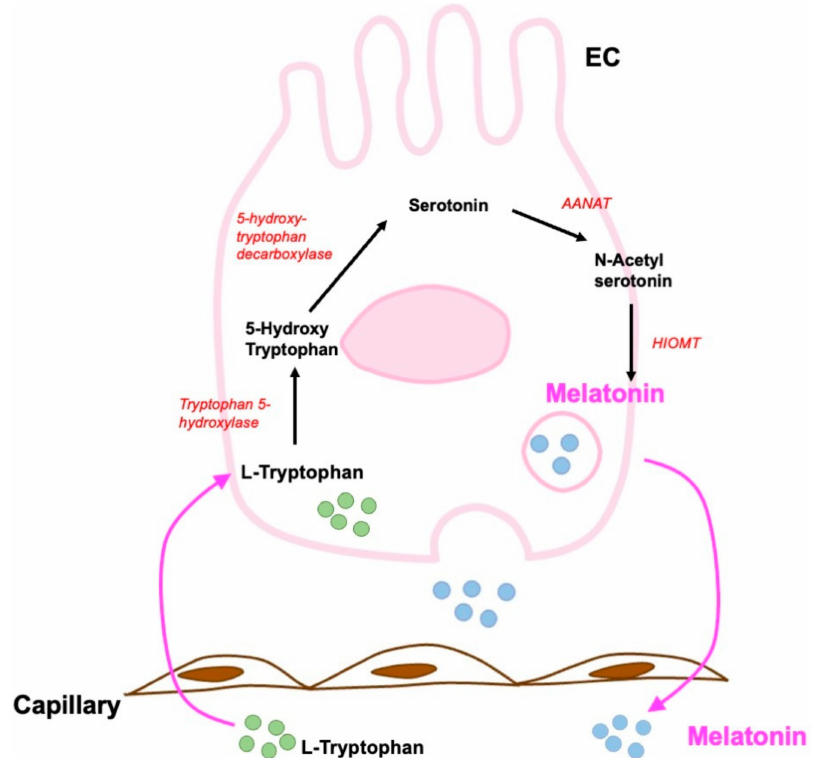
Figure 13. Schematic description of the biosynthetic pathway of melatonin in enterochromaffin cells of mammals. ANAAT: arylalkylamine-N-acetyl transferase; HIOMT: hydroxindole-O-methyltransferase; EC: enterochromaffin cell; black arrows indicate the reactions. Modified from Pal et al., 2019